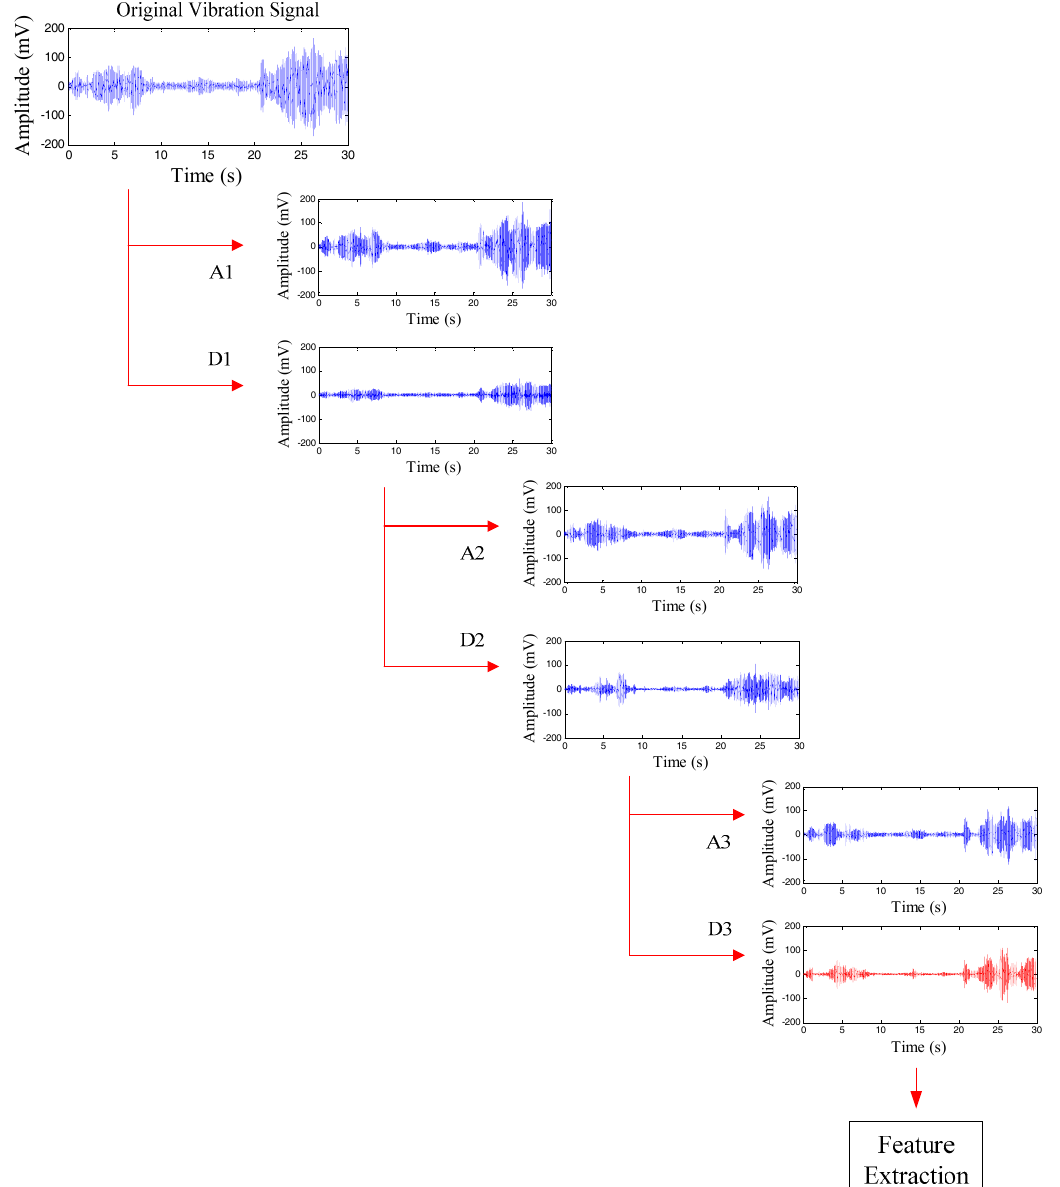
Figure 14. Three level wavelet decompositions of the vibration slew bearing signal.